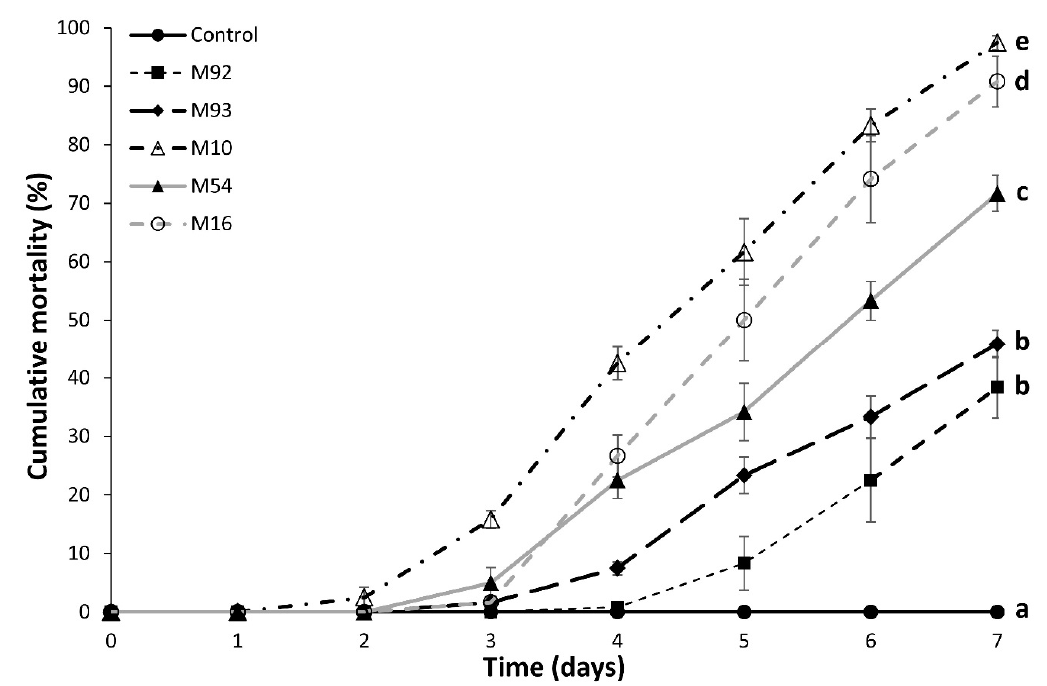
Figure 1. Cumulative mortality (±SE) of Musca domestica following exposure to different isolates of Metarhizium anisopliae at a dose of approximately 6.64 × 10 8 conidia. Survival curves of isolates labelled with the same letter are not significantly different.